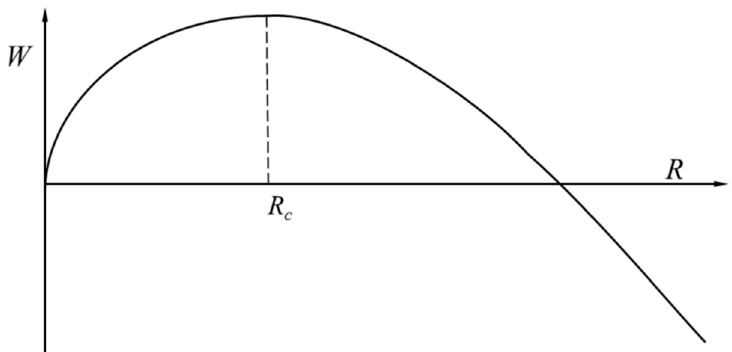
Figure 7. Relationship between nucleation free energy change and the nucleus radius of the bubble.